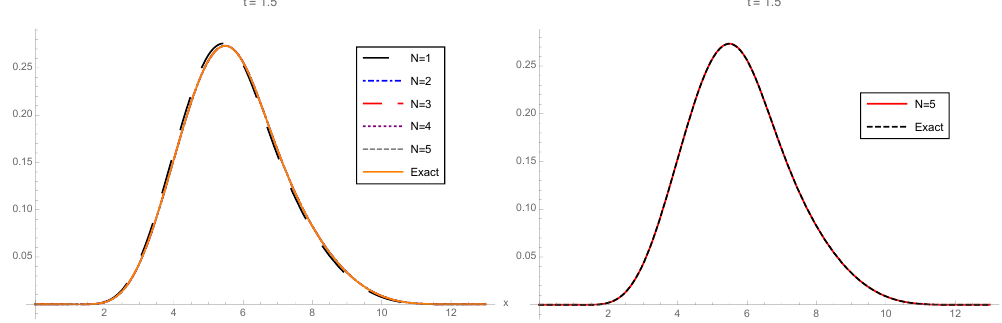
( x , t ) , of the truncated solution SP, X N ( t ) , to the random IVP (34) taking as Figure 5. Left : 1-PDF, f N 1 the order of truncation N ∈ { 1,2,3,4,5 } and the corresponding 1-PDF, f 1 ( x , t ) , of the exact solution ( x ,1.5 ) , with N = 5, is plotted together with SP at t = 1.5. Right : To facilitate the comparison, f N 1 f 1 ( x ,1.5 ) . Example